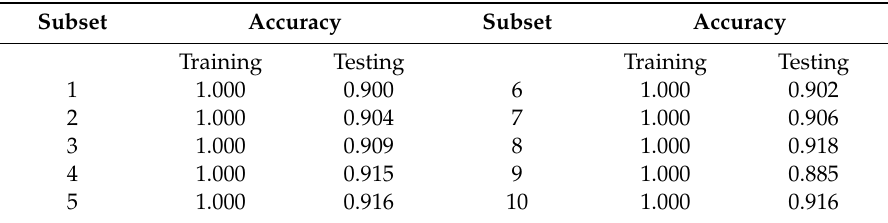
Table 4. The accuracy of 10-fold cross-validation of the RF model.